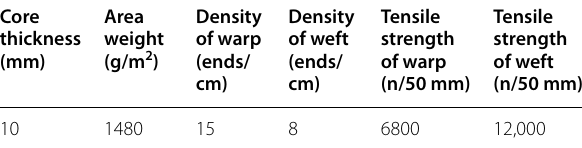
Table 3 3D-Fiberglass woven fabric specification.